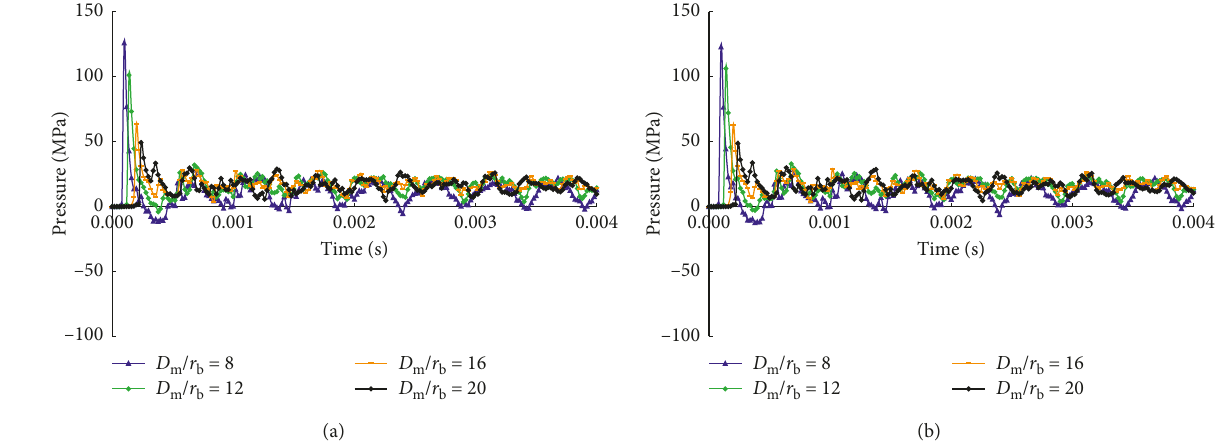
Figure 13: P-T curve of different monitoring points of #1 simulation case: (a) α